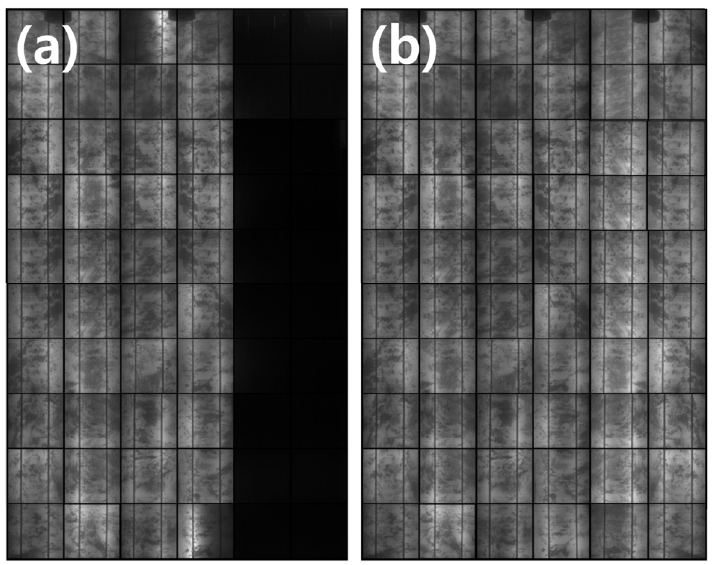
Figure 12. EL images in the module before and after recovery (240B). ( a ) EL image of 240B sample before RSB hotspot repair, ( b ) EL image of 240B sample after RSB hotspot repair.